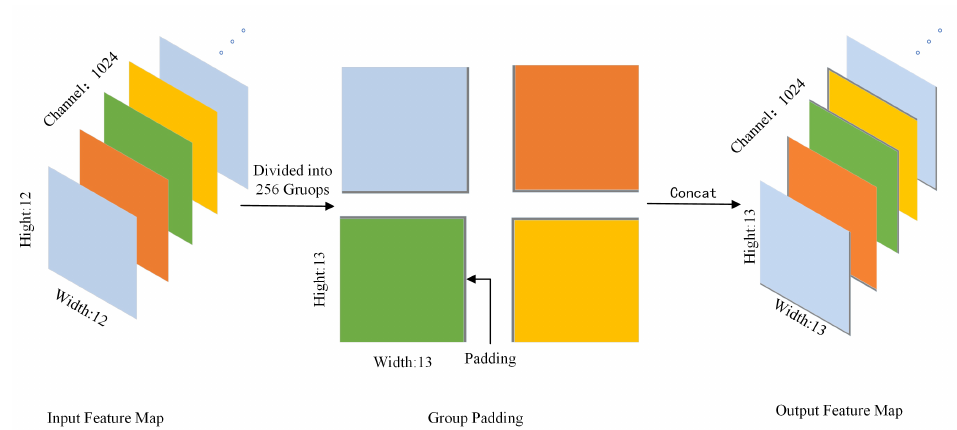
Figure 9. Group padding diagram.